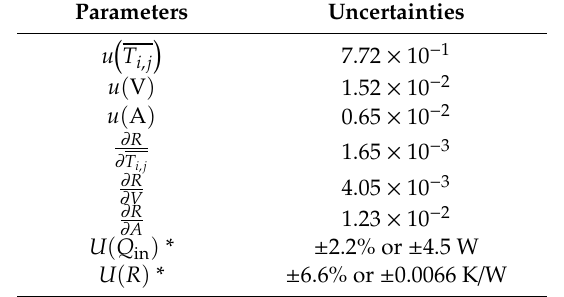
Table 2. The uncertainties and sensitivity coe ffi cient of parameters, Q in = 200 W.